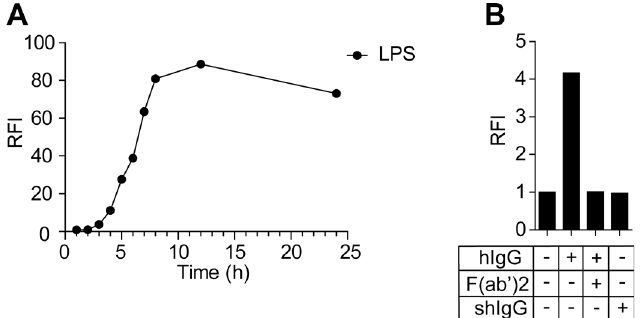
Fig 2. Detection of NF- κ B activation by U937-NF- κ B cells. Cells were treated with 10 μ g/ml LPS (A), and the activation was detected for 24 h. Cells subjected to the medium only served as a negative control. The activation reached the maximum at 12 h. Cells were also activated on 10 μ g/ml human immunoglobulin G (hIgG) coated surface (B). For negative controls, cells subjected to the medium only or to 10 μ g/ml soluble human immunoglobulin (shIgG) on uncoated surface were used. The activation was tested on human immunoglobulin coat in the presence of 10 μ g/ml goat-anti human immunoglobulin (F(ab ’ ) 2 ).